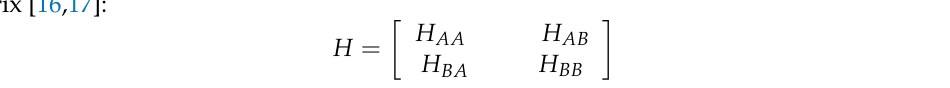
( c ) Figure A1. Single-layer graphene. ( a ) Real space and 𝑎 1 ⃗⃗⃗⃗ , 𝑎 2 ⃗⃗⃗⃗ basis vectors; ( b ) reciprocal space and 𝑏 1 ⃗⃗⃗ , 𝑏 2 ⃗⃗⃗⃗ basis vectors; ( c ) Brillouin zone.